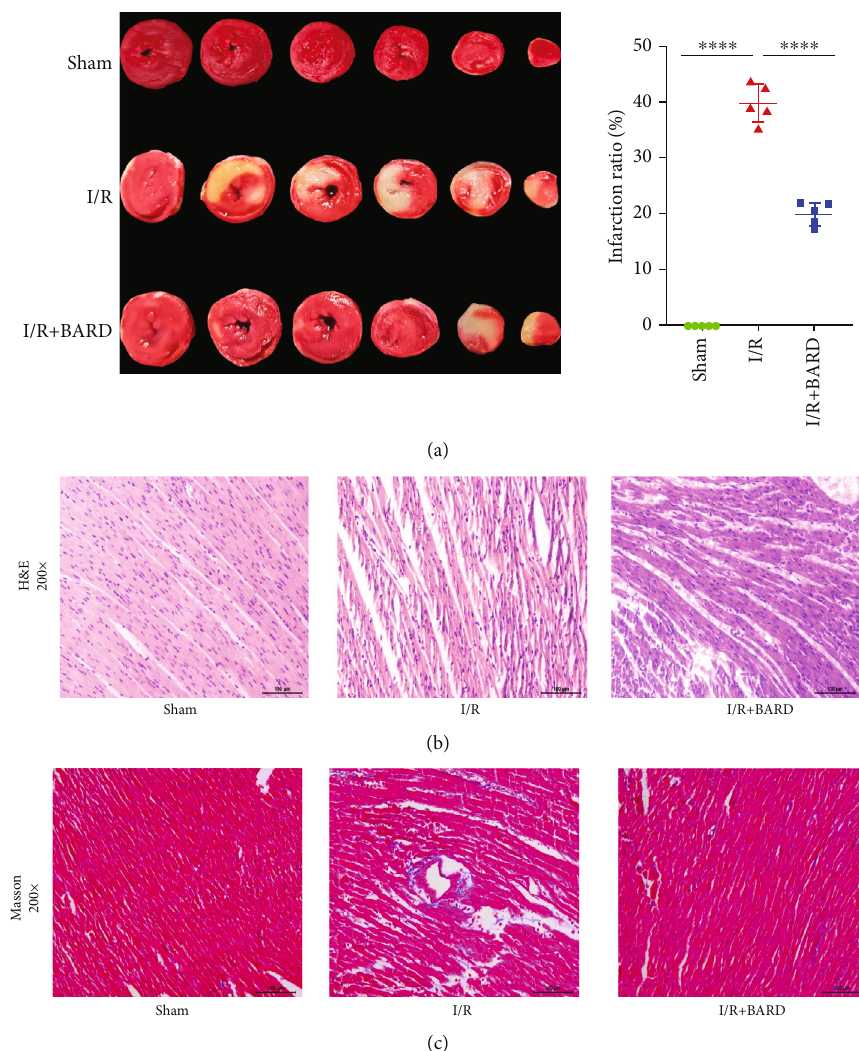
Figure 2: Bardoxolone methyl reduces the myocardial infarct size and decreases pathological changes in cardiomyocytes. (a) Triphenyltetrazolium chloride staining (TTC; n = 5 ), (b) H&E staining, and (c) Masson staining. Magni fi cation of microscope: × 200. Scale bar: 100 μ m. ∗∗∗∗ P < 0 : 0001